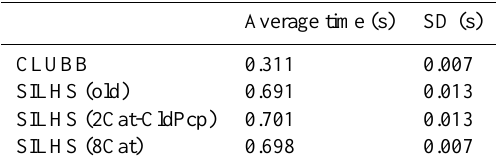
Table 7. Cumulative run time of CLUBB and the different SILHS configurations over an 864-timestep RICO simulation. Each SILHS configuration uses eight sample points. The means and standard de- viations of five simulations are shown in the table. All times are in seconds. The two nCat methods (2Cat-CldPcp and 8Cat) show no significant increase in computation time as compared to the origi- nal SILHS importance sampling method. All SILHS methods, with eight sample points, are more expensive than